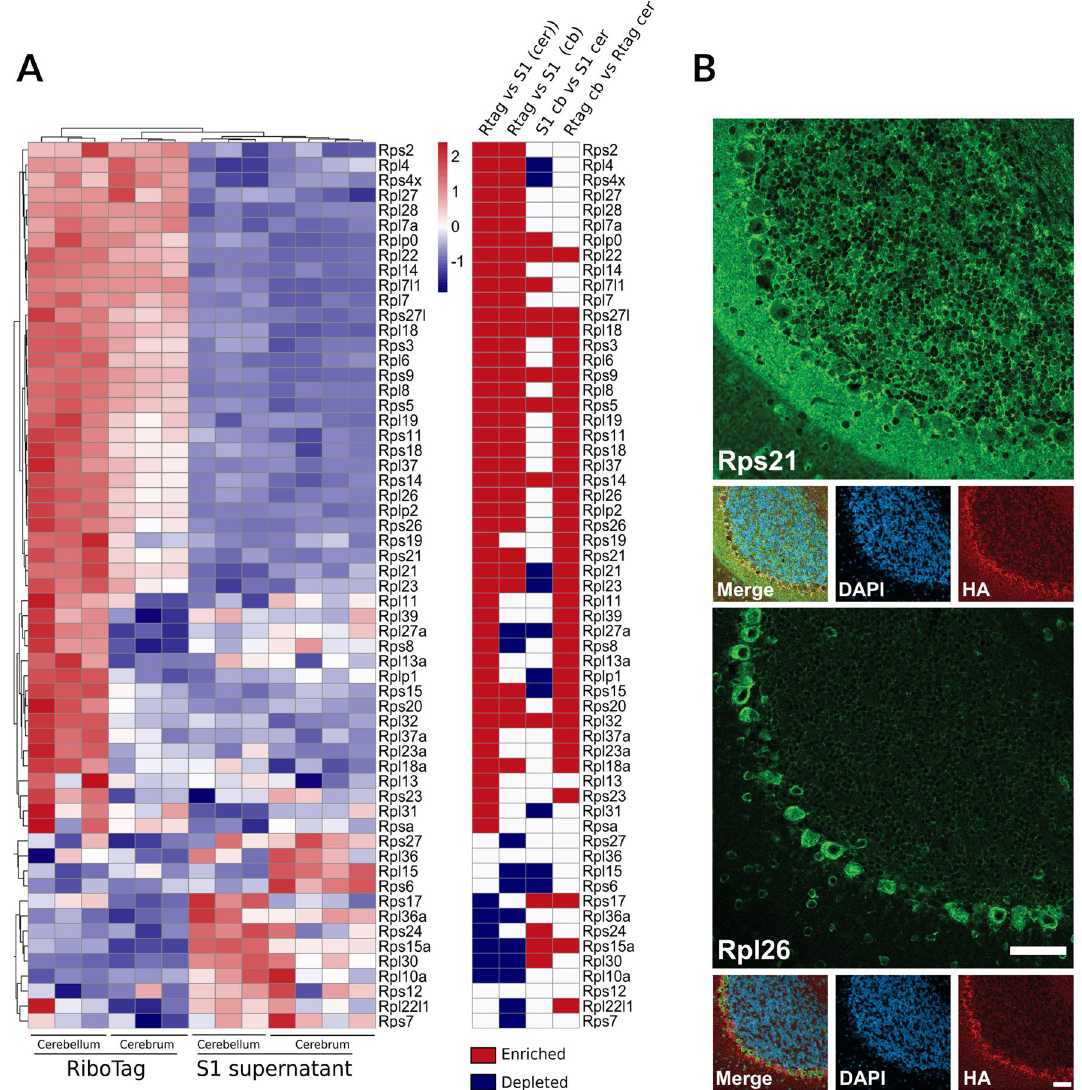
Figure 7. ( A ) Heatmaps of FPKM values for significantly (FDR < 0.05) enriched and depleted (RiboTag vs input) ribosomal proteins in cerebellum and cerebrum. ( B ) Immunofluorescence shows disparity between Rps21 and Rpl26 in the cerebellum. Scalebar = 50